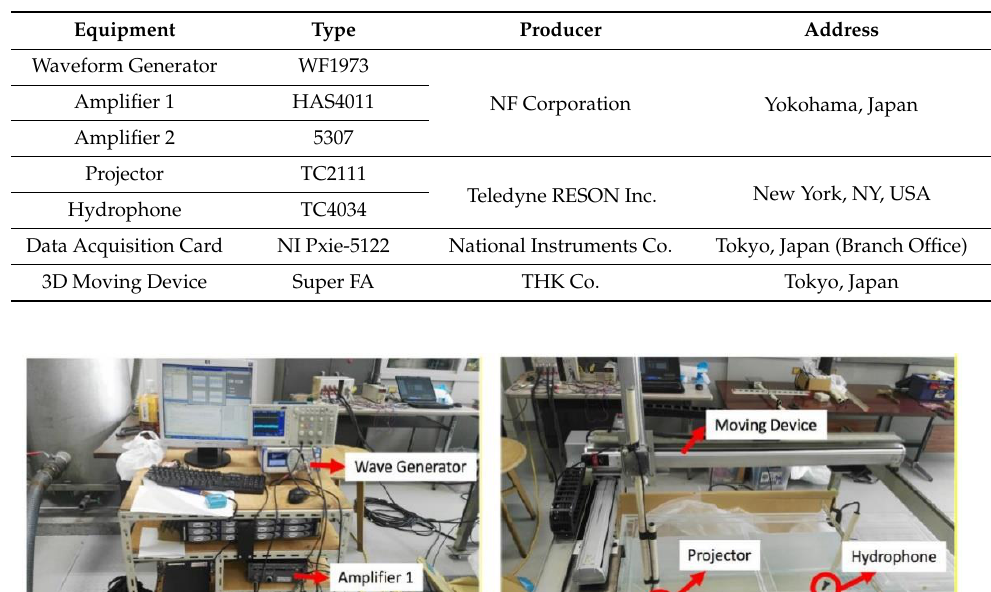
Figure 3. Structure of experiment system. Table 1. Equipment information.